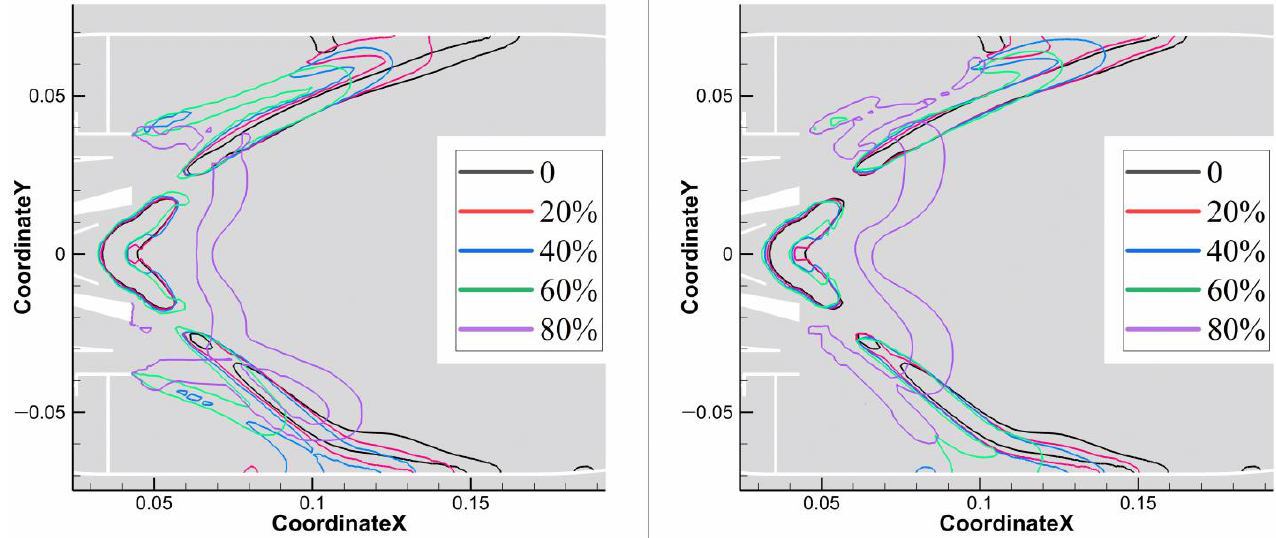
Figure 9. The high heat release rate zones in the combustion